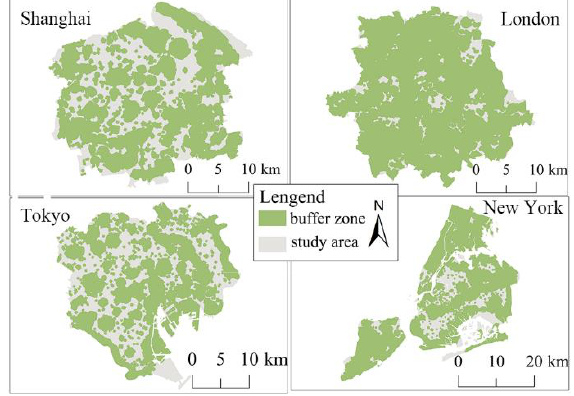
Figure 4. The buffer zones of the four study areas